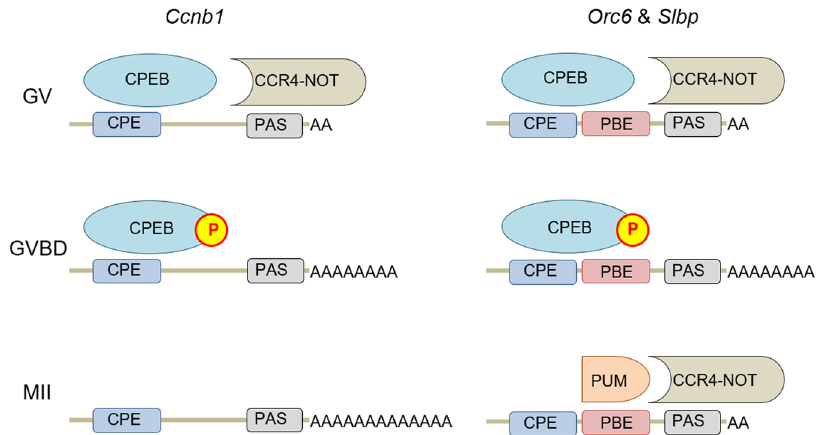
Figure 9. Model for differential poly(A) tail length dynamics during meiotic maturation. In immature (GV) oocytes, the CPE of Ccnb1 , Orc6 and Slbp provides a binding site for CPEB, which directly or indirectly recruits the CCR4-NOT deadenylase complex. After maturing oocytes undergo GVBD, CPEB becomes phosphorylated. This may inhibit its ability to interact with CCR4-NOT. CPEB nonetheless prevents association of PUM proteins with the nearby PBE sites. In the absence of an associated CCR4-NOT activity, polyadenylation is favoured. Later during maturation, CPEB becomes degraded. This permits PUM proteins to associate with the previously masked PBE sites on Orc6 and Slbp , enabling CCR4-NOT to be recruited to the mRNA. Thus, the mRNA becomes deadenylated. In Ccnb1 , by contrast, which lacks a PBE in the appropriate location, CCR4-NOT is not recruited and the mRNA continues to be